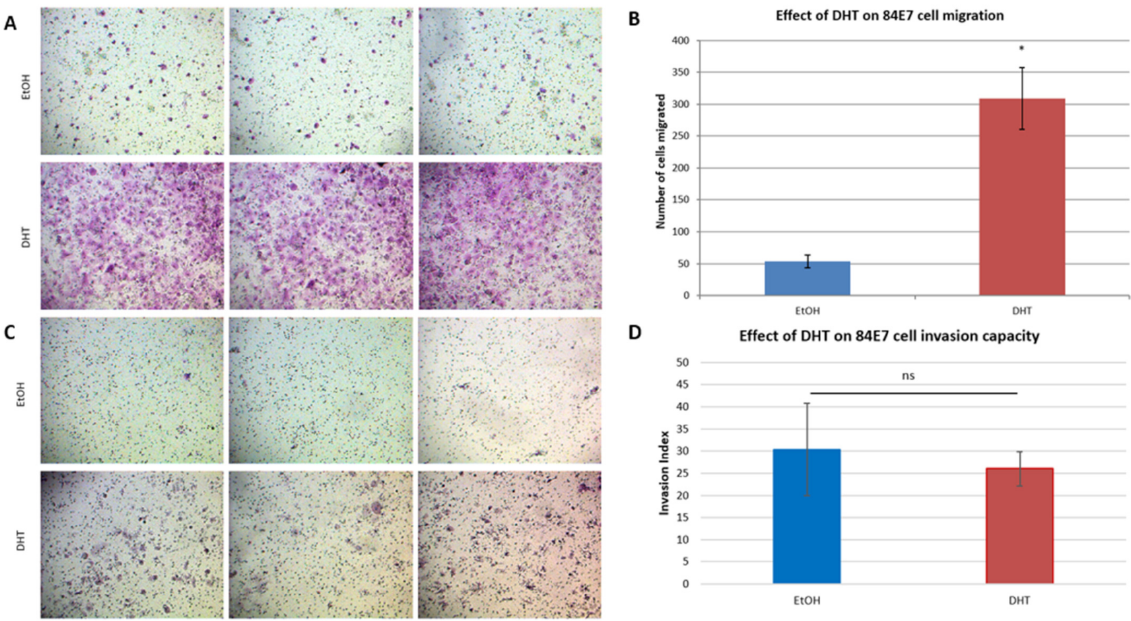
Figure 11. Migratory and invasive potential of 84E7 cells with AR activation: ( A ) Representative images of migrated 84E7 cells in the presence and absence of AR activation at 10 × magnification. ( B ) Quantification of migrated cells. A six-fold increase in migration was observed in DHT-treated cells. ( C ) Representative images of 84E7 cells invading through the lower surface of the Matrigel insert membrane at 10 × magnification. ( D ) Invasion index of EtOH- and DHT-treated 84E7 cells. Invasion index is calculated as mean number of cells invading the Matrigel insert membrane divided by the mean number of cells migrating through the control insert membrane × 100. EtOH-treated = 30.38; DHT-treated = 26.09. No significant change in the invasion potential of AR-induced senescent cells (* p -value < 0.05, ns = not